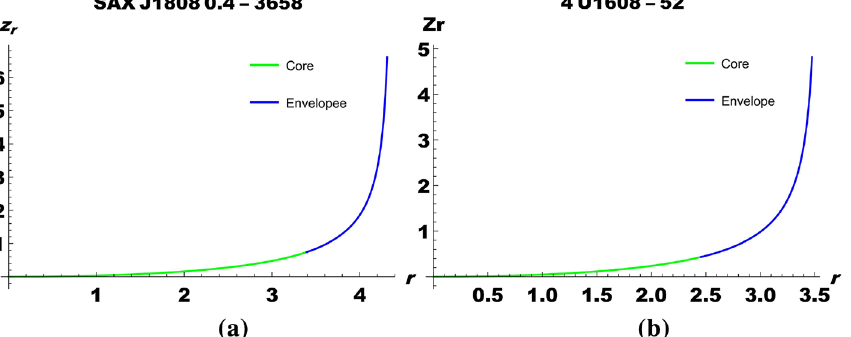
Fig. 6 Variation of red-shift with radial